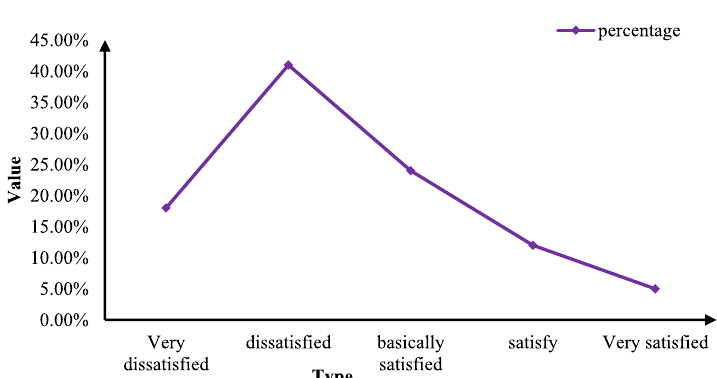
Fig. 10 Citizens’ satisfaction survey on the government’s governance against internet fraud